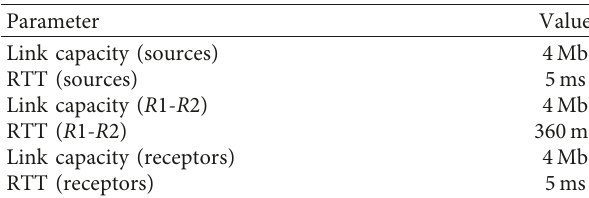
Table 4: Parameters of Scenario 1.